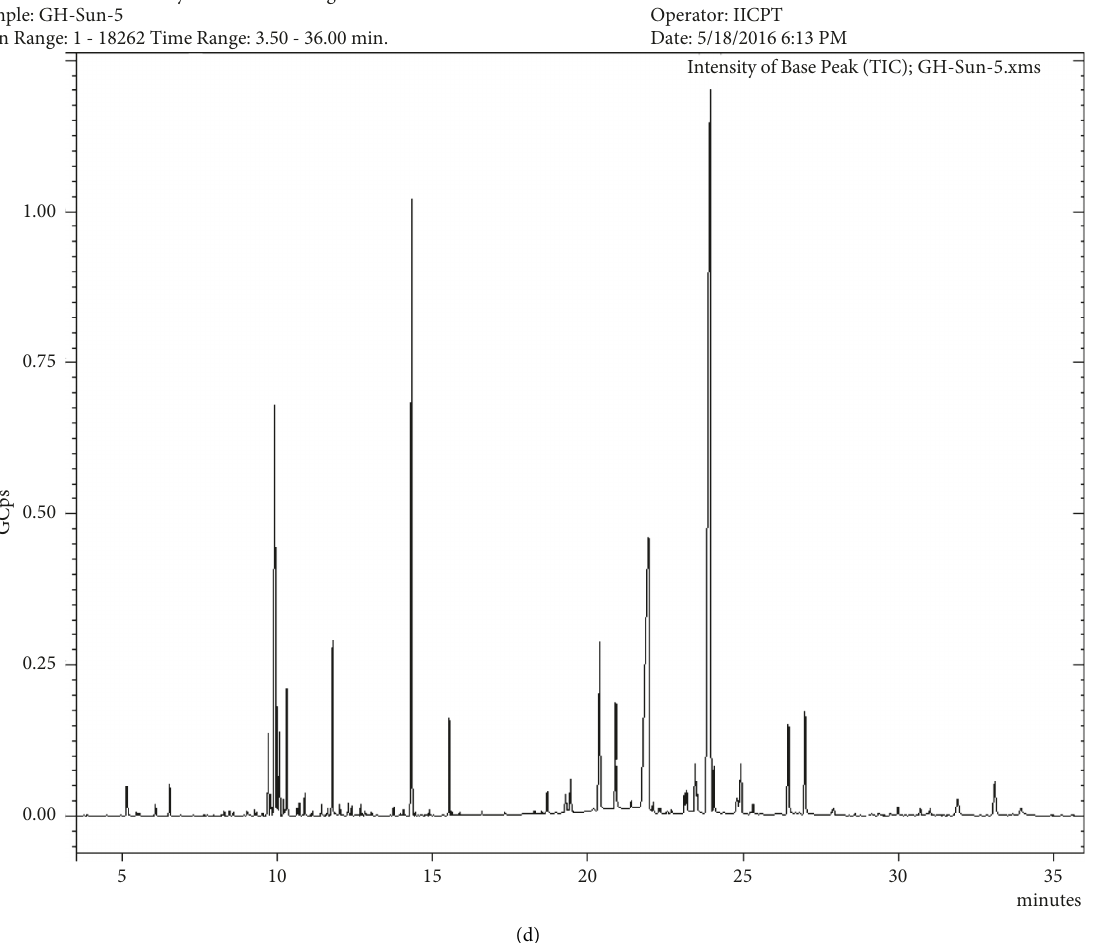
Figure 2: (a) Chromatograms of the volatile and bioactive compounds of the ethanol extract of fresh ginger rhizome. (b) Chromatograms of the volatile and bioactive compounds of the ethanol extract of CSD ginger rhizome. (c) Chromatograms of the volatile and bioactive compounds of the ethanol extract of SSSD ginger rhizome. (d) Chromatograms of the volatile and bioactive compounds of the ethanol extract of OSD ginger